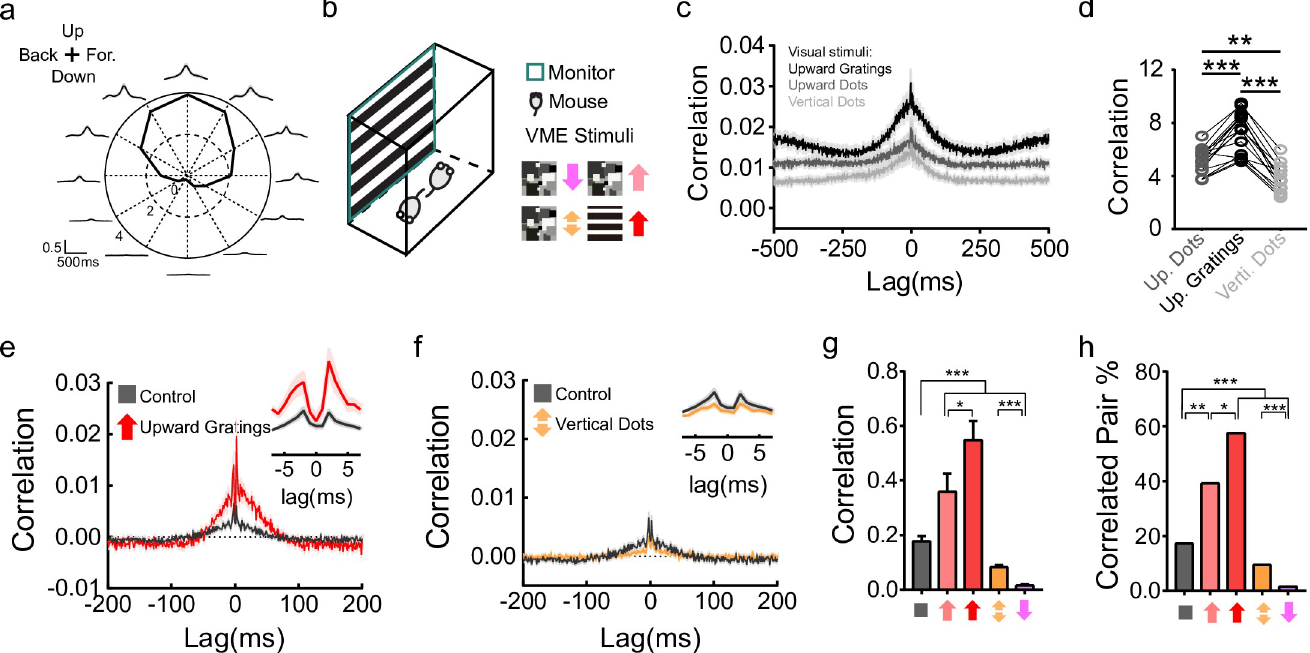
Fig 3. Correlated activity underlies VME-induced changes in ooDSGCs. (a) Polar plot and cross-correlograms showing levels of correlated activity (averaged across V-DSGC pairs) induced by different directions of motion stimuli. Upward motion induces the highest spike time correlation; downward motion induces almost no spike time correlation among V-DSGCs. Stimulus: the same stimulus as used for upward and downward dots VME, except also with motion in 10 other directions. Cross-correlation calculation was done with a 25-ms time bin. Stimulus effect is not removed. (b) Illustration of the VME stimuli that induce different levels of correlated activity. For each stimulus, left, spatial pattern; right, color code with direction of motion. (c) Spike time cross-correlograms under three different visual stimuli: upward gratings (red), upward dots (pink), and vertical dots (orange). Solid lines, average cross-correlograms; shade areas, ± SEM. Only cross- correlograms for V-DSGC pairs are included. Note the cross-correlograms shown here intentionally do not remove the effect of the stimuli, to best represent the amount of difference in total correlated activity elicited by these stimuli. (d) Comparison of total correlated activity evoked by three visual stimuli shown in (c). Correlation is computed as described in 2d. n = 16 pairs; ��� p < 0.001, �� p < 0.01, paired t test. (e,f) Average cross-correlogram of V-DSGC pairs after VME training with upward gratings (e) and vertical dots (f). Cross-correlograms of all V-DSGC pairs are averaged. Responses used to calculate the cross-correlograms were recorded during travelling gratings. Control, gray, n = 139; upward VME, red, n = 33; vertical VME, orange, n = 253; shaded areas, ± SEM. Insets are close-up views with 1-ms bin size. (g) Quantification of correlation strength from cross-correlograms in 2b, 3e, and 3f. Correlation is computed as described in 2d. � p < 0.05, ��� p < 0.001, unpaired t test. Error bars, SEM. (h) Proportion of V-DSGC pairs with measurable gap junction connections. The proportions of correlated pairs in all V-DSGC pairs show significant difference, with upward VMEs higher than control and vertical VME lower than control (chi-squared test, ��� p < 0.001; �� p < 0.01). In addition, the upward gratings VME is significantly higher than upward dots VME (chi-squared test, � p < 0.05). Data for this figure are in S3 Data. ooDSGC, ON-OFF direction selective ganglion cell; VME, visual motion experience.